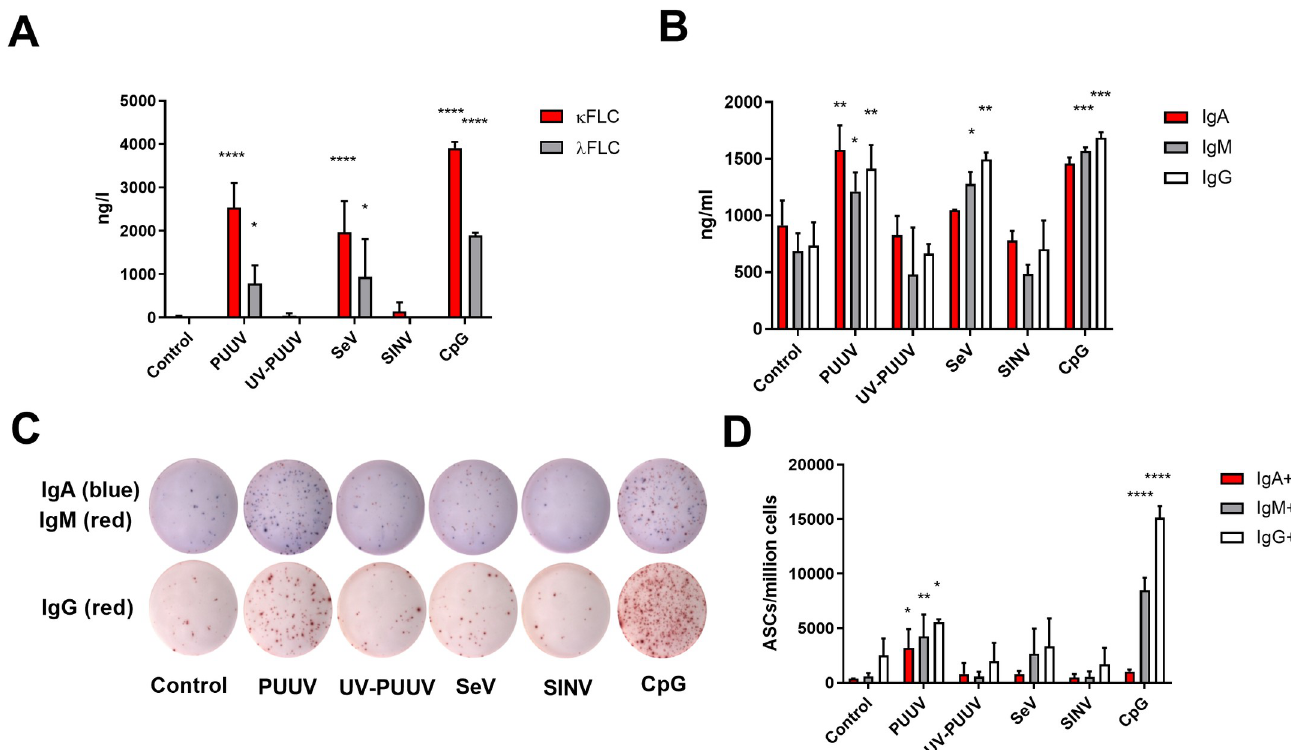
Fig 7. PUUV activates B cells to produce FLCs and whole Igs. B cells were enriched from blood of 3 healthy volunteers and infected with live or UV-inactivated purified PUUV, together with Sendai and Sindbis viruses, for comparison (multiplicity of infections for all viruses equals 1). The TLR9 agonist CpG and no treatment were used as a positive and negative controls for B cell activation, respectively. After culturing for 8 days, kappa and lambda FLCs in (A) and IgA, IgM and IgGs in (B) were measured from cell supernatants. Remaining cells were subjected to IgA, IgM and IgG-specific antibody secreting cell (ASC) quantification using Elispot. IgA + and IgM + ASCs were simultaneously detected in one well, using AP-conjugated anti-IgA and HRP-conjugated anti-IgM Abs, and IgG + ASCs in a separate well using HRP-conjugated anti-IgG Ab. Representative Elispot images from one donor are shown in (C), and ASC quantification per input cell number measured from all donors in (D). Significant differences of each treatment group, as compared to non-treated cells, were assessed using two-way ANOVA and Dunnett’s multiple comparison tests. � p < 0.05, �� p < 0.01, ��� p < 0.001.